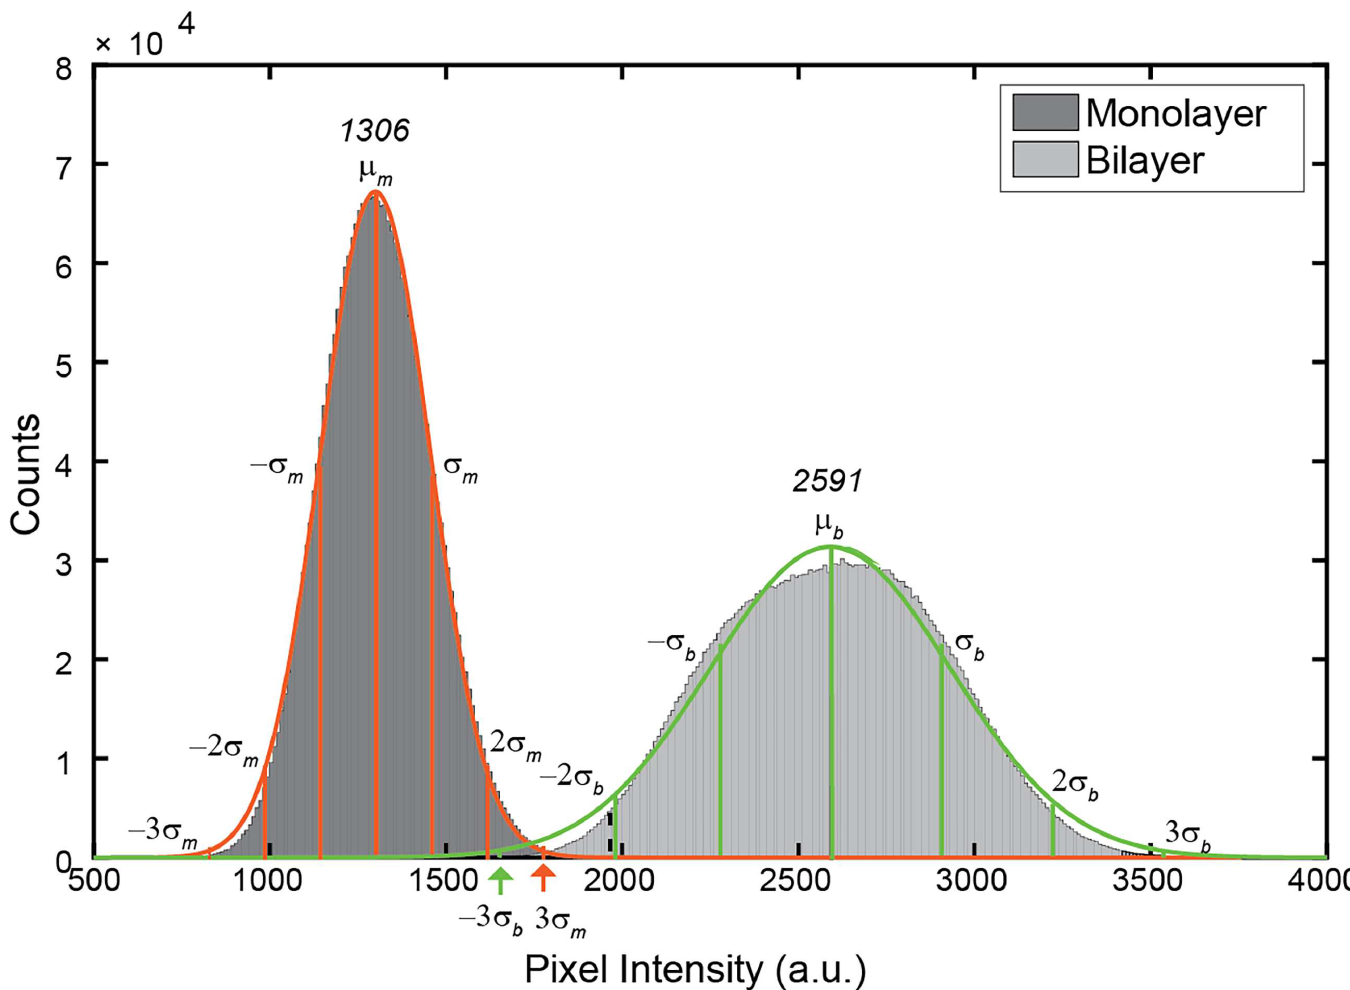
Fig 4. Histogram of pixel intensities of lipid bilayers on ox-PDMS and lipid monolayers on PDMS. Each histogram is obtainedfrom N = 10 images, corresponding to a total count of ~ 2.6 × 10 6 pixels per histogram. The orangecontinuous line is a fit of a normal distribution to the histogram for the monolayers. The green continuousline is a fit of a normal distribution to the histogram for the bilayers. The mean intensity of the monolayer, μ m = 1360 is half the mean intensity of the bilayer, μ b = 2591. The histogram of pixel intensitiesbetweenthe bilayers and monolayers do not overlap up to ~ 2.5 σ from the mean. The clear separation of the distribution of pixel intensities allows classification of pixels as being monolayers or bilayers in images that potentiallyhave mixed compositionsof monolayers and